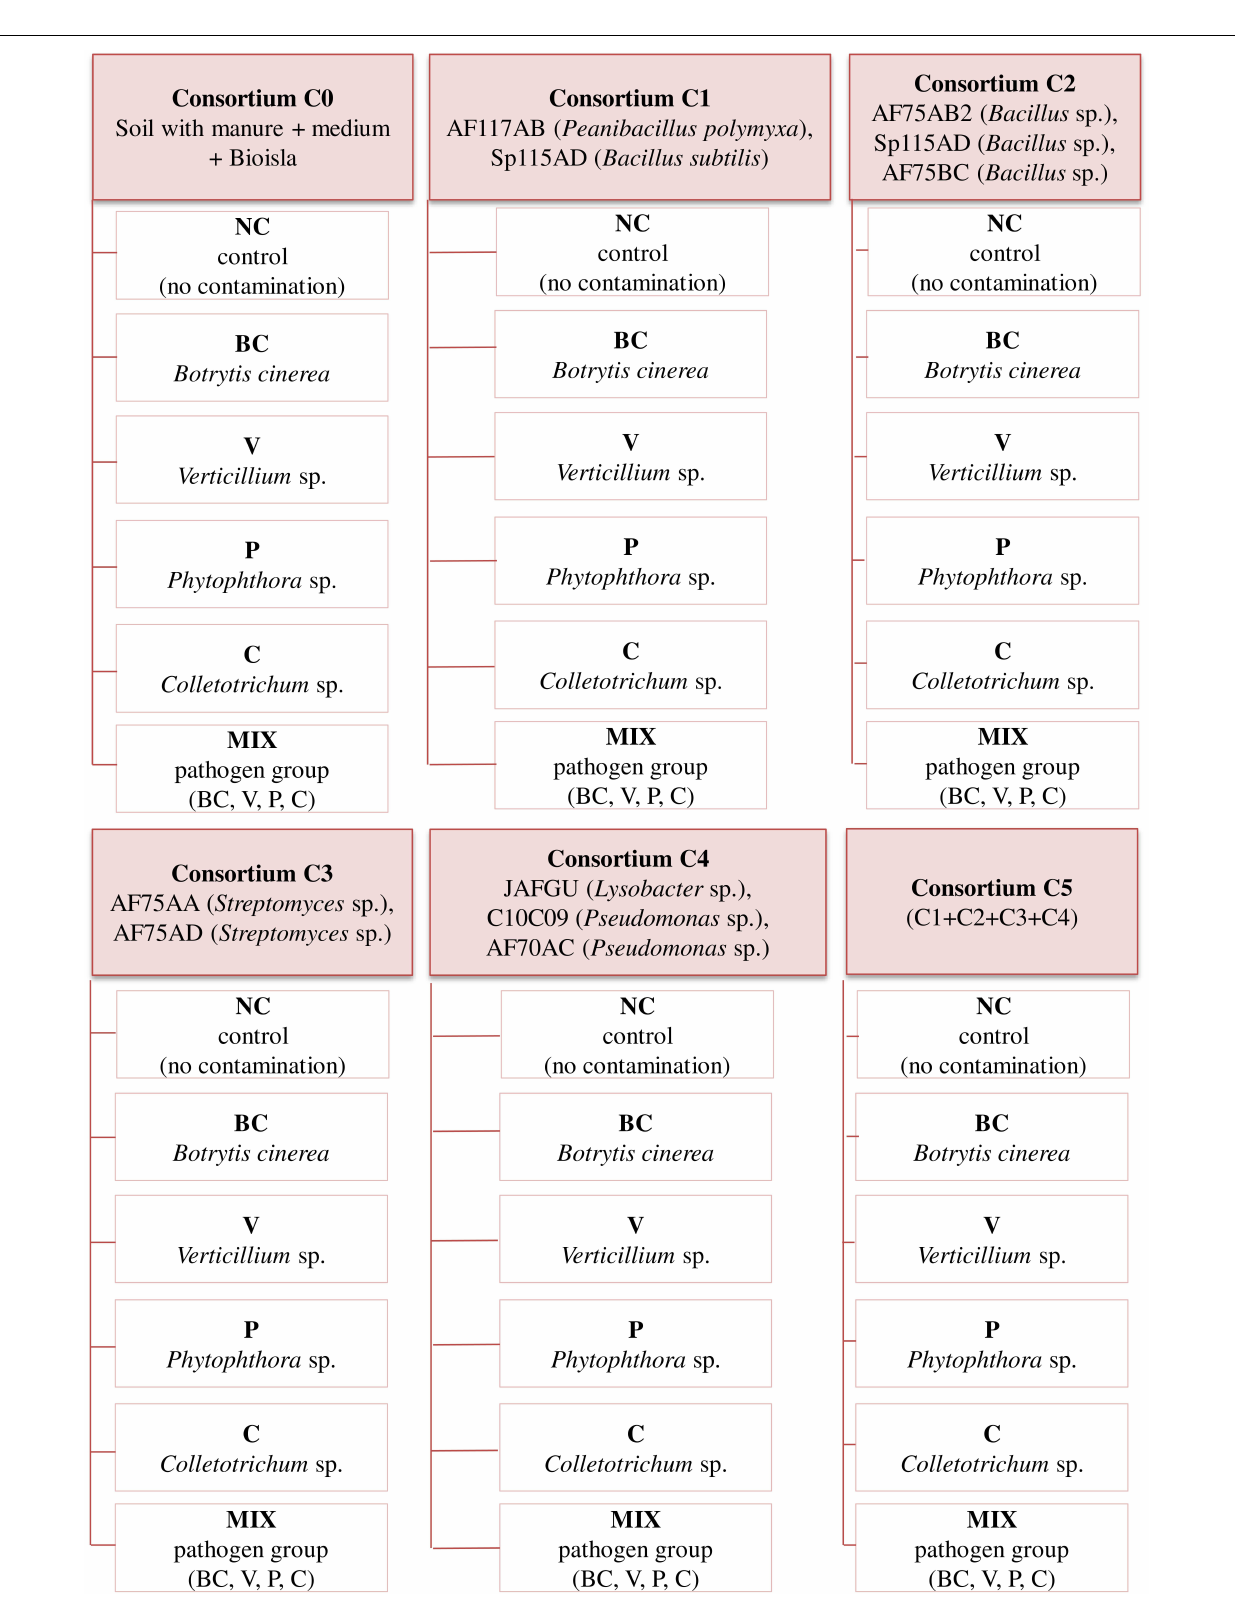
Frontiers in Plant Science |